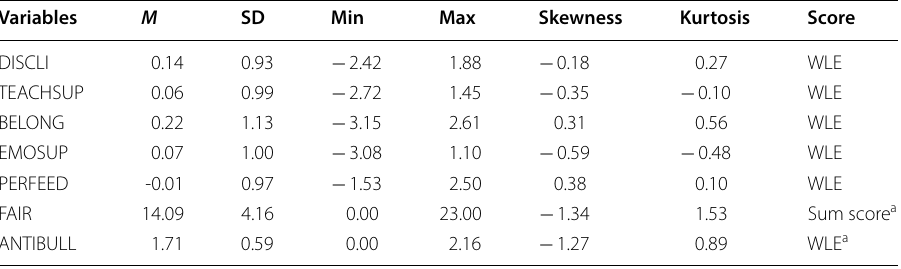
Table 2 Descriptive statistics, range, skewness and kurtosis for the school climate variables